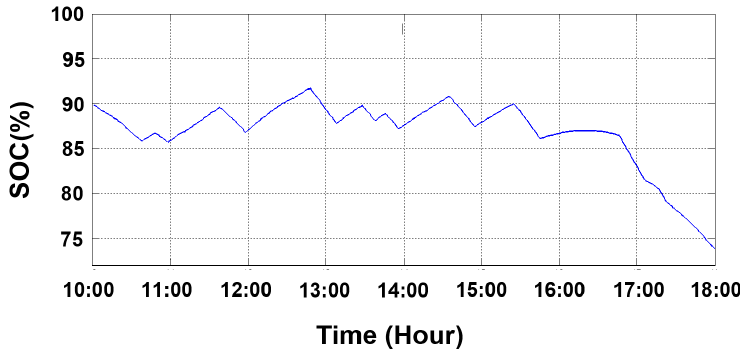
Figure 10. Rule-based EMS: ESS SOC.